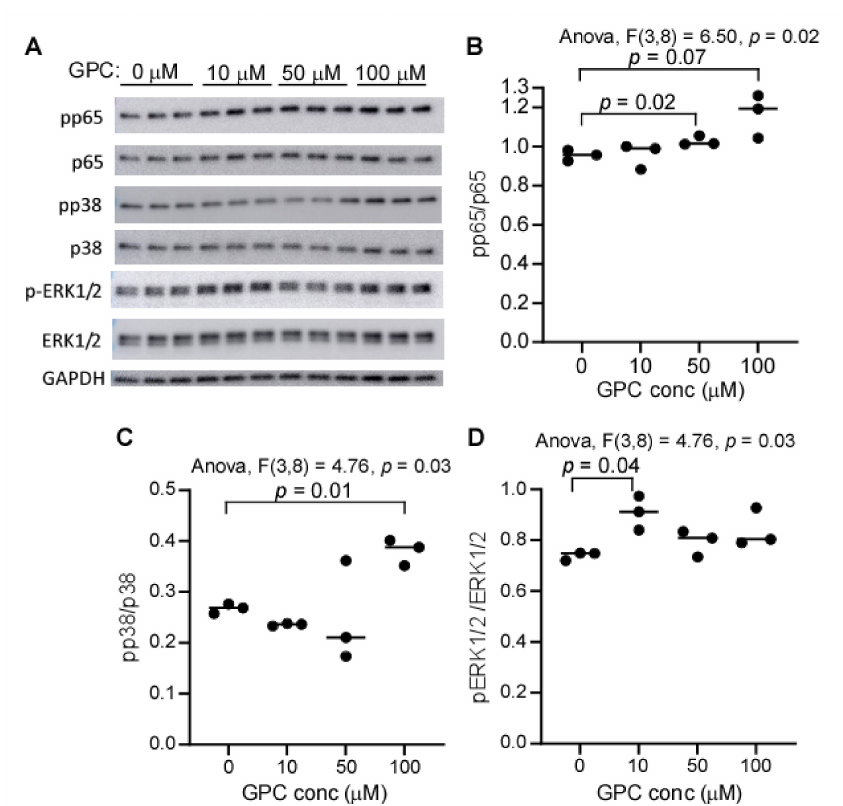
Figure 11. GPC activates NF κ B and MAPK signaling in HCAEC. ( A ) SDS-PAGE/Western blotting analysis of ERK1/2, p38, and p65, and their respective phospho-proteins. HCAEC cells were treated with different concentrations of GPC for 20 min, and the lysate was employed to run SDS-PAGE followed by immunoblotting. Each well was loaded with 4 µ g protein equivalent of cell lysate. ( B – D ) The relative intensity of phospho-protein to its native protein, as quantified by ImageJ software. p values were calculated by one-way ANOVA followed by Student’s t test, and only p values less than 0.10 are